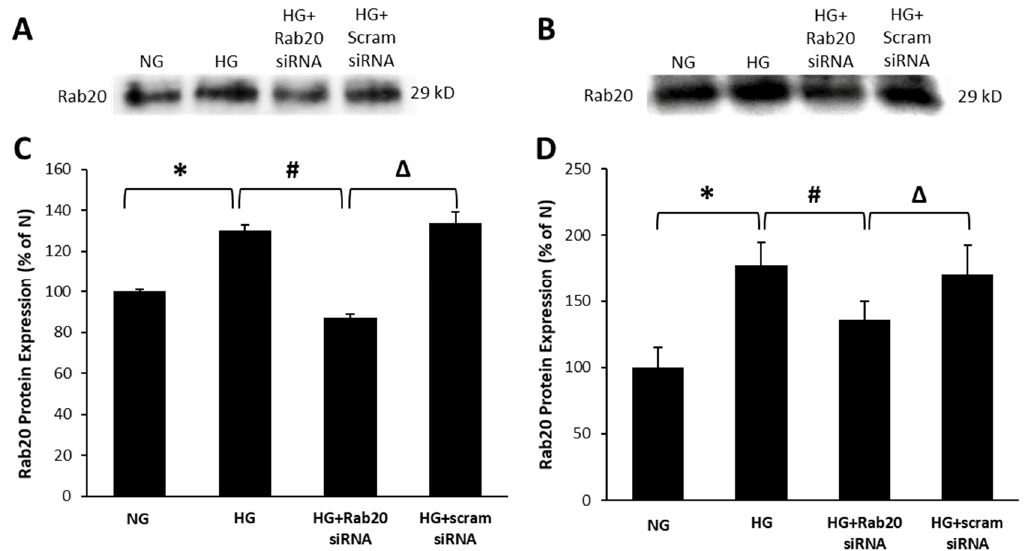
Figure 1. Effects of high glucose (HG) and Rab20 siRNA on Rab20 expression in retinal endothelial cells (RRECs) and rMC-1. Representative images of WB using immunoprecipitated Rab20 protein shows HG significantly upregulates Rab20 expression in ( A ) RRECs and ( B ) rat retinal Müller cells (rMC-1). Graphical illustration of cumulative WB data indicates that cells grown in HG and transfected with Rab20 siRNA exhibit significantly reduced Rab20 expression compared to that of cells grown in HG alone in both ( C ) RRECs and ( D ) rMC-1. Data are expressed as mean ± SD. * p < 0.05, n = 6; # p < 0.05, n = 6; Δ p < 0.05, n = 6.